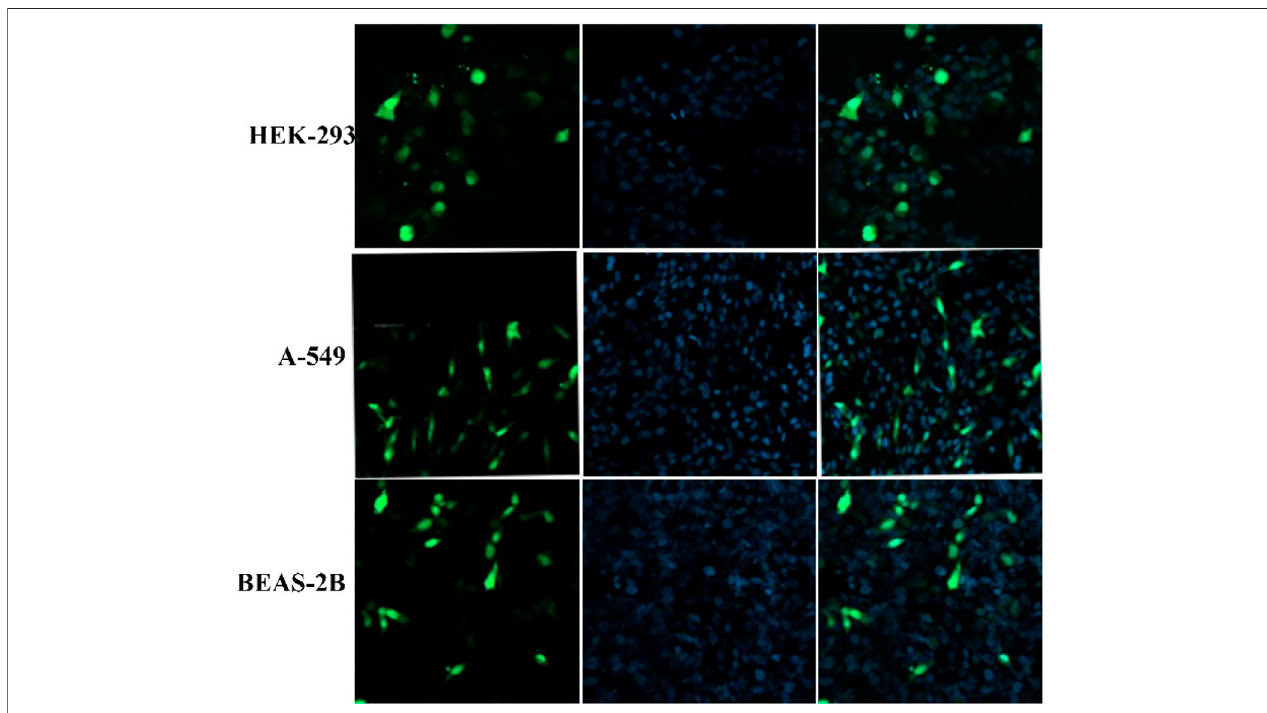
FIGURE 10 | Confocal microscopy images showed the cellular uptake of PEGylated nanoparticles after 4 h of incubation.